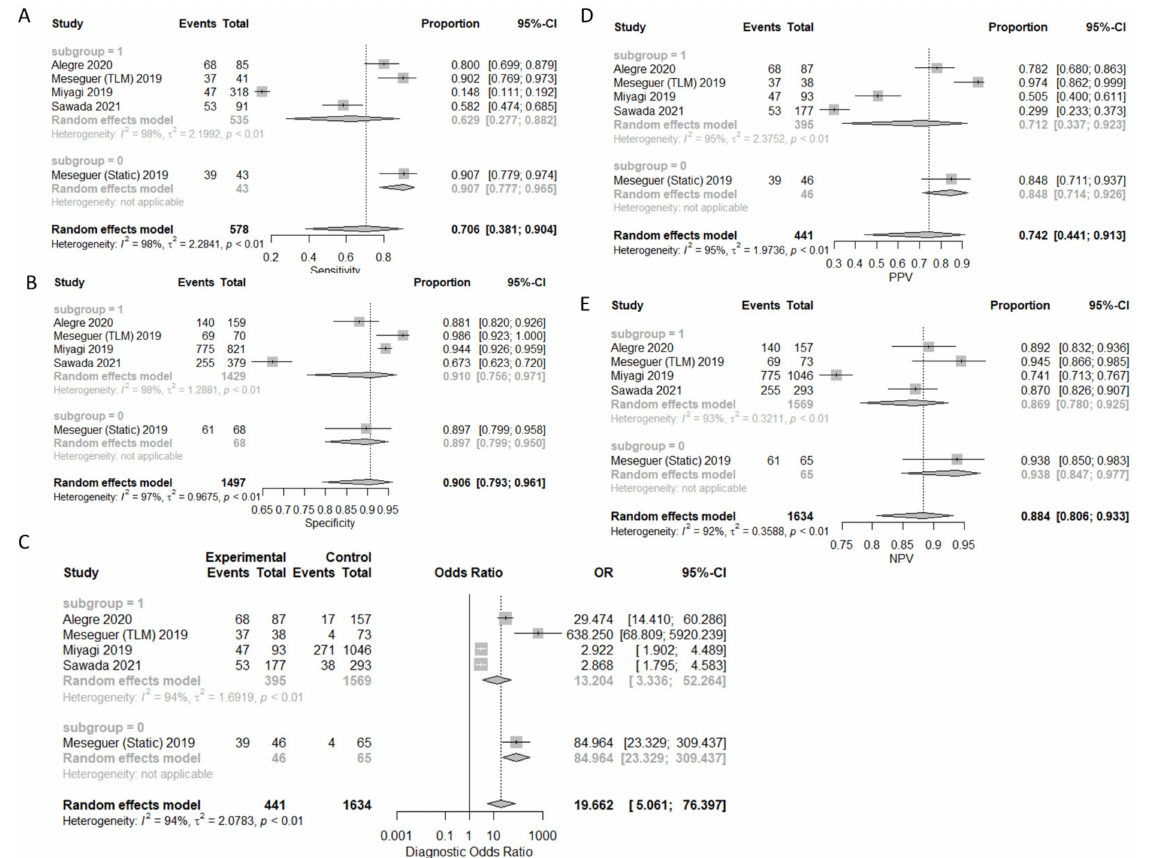
Figure 2. Forest plots representing: ( A ) sensitivity; ( B ). specificity; ( C ) DOR; ( D ) PPV; ( E ) NPV of the live birth prediction outcome. Subgroup “0” represents static images as the type of input, and subgroup “1” represents time-lapse.